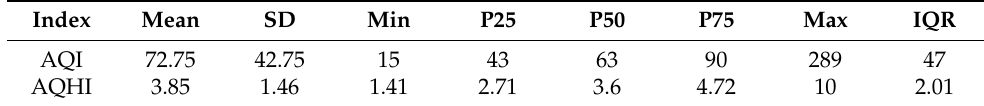
Table 5. Comparative statistics of the AQI and AQHI in Beijing from 2018 to